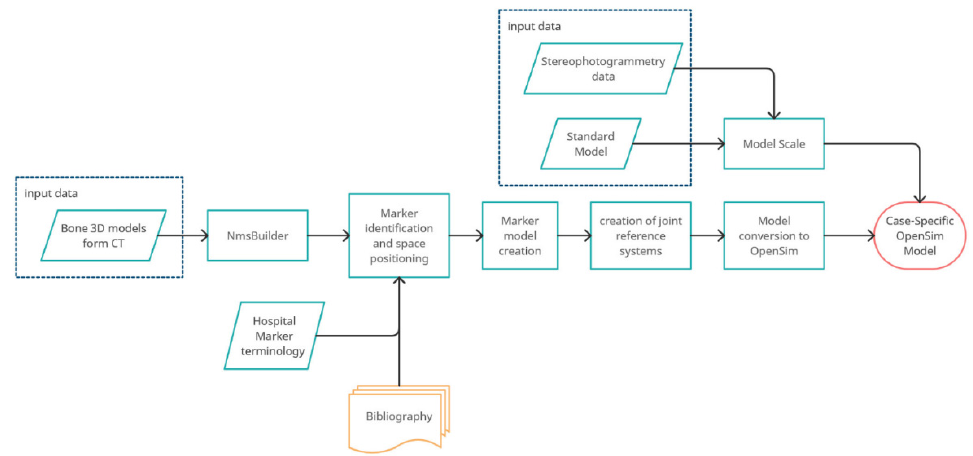
Figure 5. Flowchart describing the creation of OpenSim model using NmsBuilder and 3D TC models.